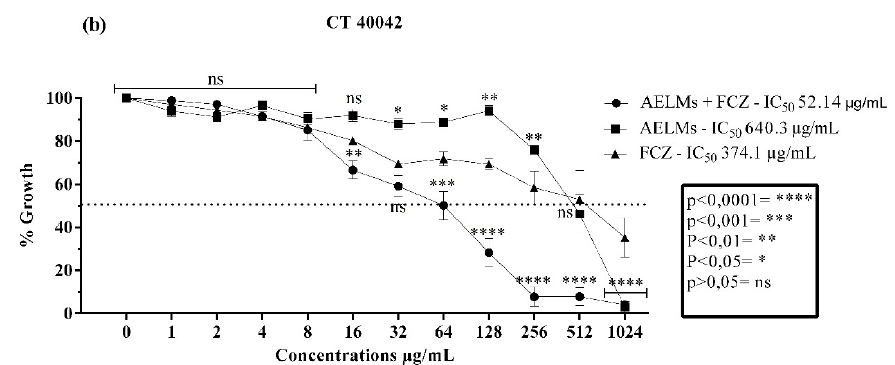
Figure 4. Cell viability curves and IC 50 values (concentration responsible for 50% colony growth inhibition) of the Mesosphaerum suaveolens aqueous leaf extract (AELMs) and fluconazole (FCZ) in µg/mL against Candida tropicalis . ( a ) Antifungal activity against strains of Candida tropicalis LM 23. ( b ) Antifungal activity against strains of Candida tropicalis INCQS 40042.